Question: In a single sentence, describe what this figure presents.
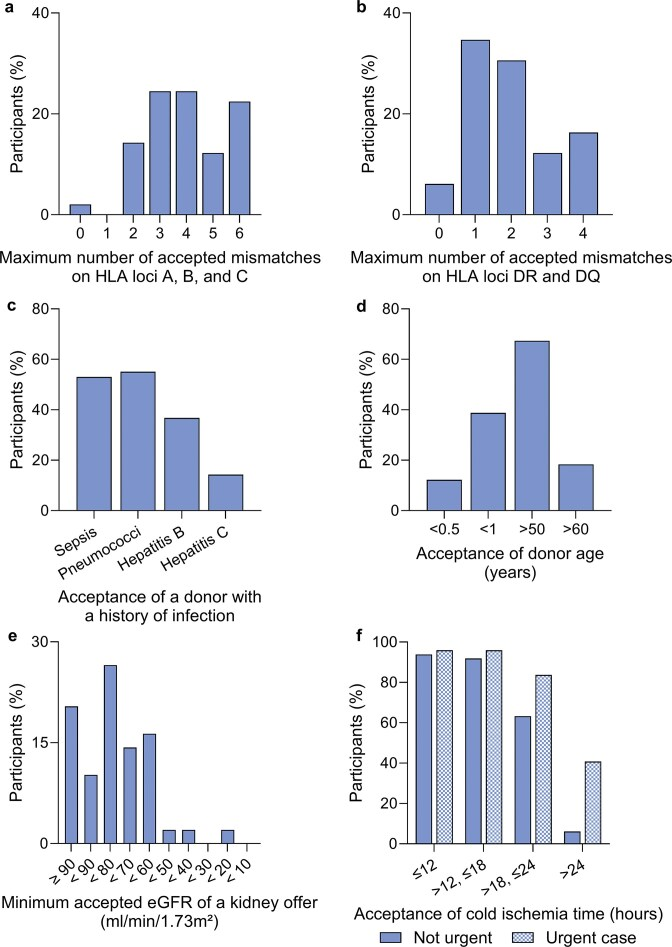
Answer: Precedent survey results. (a) Mostly a maximum of three (12/49, 25%) or four (12/49, 25%) MMs on HLA loci A, B, and C was accepted. Corresponding survey questions: ‘ Regarding ‘acceptable’ MM when a kidney is offered, what is the maximum total number of MM on HLA A, B, and C you would accept: ’. (b) The total number of acceptable MM on HLA DR and DQ was 1 (17/49, 35%) or 2 (15/49, 13%) at maximum in most cases. Corresponding survey questions: ‘ In our center, in order to accept a first kidney, transplant we allow the following maximum total number of MM on HLA DR and DQ: ’. (c) A history of sepsis or an infection with pneumococci in the donor was accepted in 55% (26/47) and 56% (27/48) of the cases, respectively, whereas a history of hepatitis C was mostly declined (42/49, 86%). Corresponding survey question: ‘ Would you accept a kidney from a donor with: ’. (d) Small donors aged <0.5 years were mostly declined (41/47, 87%). However, donors of >50 years were accepted in the majority of cases (33/49, 67%), whereas donors >60 years were mostly declined (40/49, 82%). Corresponding survey question: ‘ Regarding the age of the donor, you would accept a kidney from a donor who is aged: ’. (e) Most responses on the minimum accepted eGFR of an offered kidney ranged between ≥90 and <60 ml/min/1.73 m 2 (43/49, 87.76%). Corresponding survey question: ‘ Regarding the donor’s kidney function, what is the minimal eGFR of an offered kidney that you would accept? ’. (f) CIT of >24 hours were declined in almost all cases (42/45, 93%); however, in urgent cases (marked in a hatched pattern) 43% (20/47) accepted a CIT of >24 hours. Corresponding survey questions: ‘ With regard to CIT, would you accept a deceased donor kidney with CIT: ’ and ‘ With regard to CIT, in clinically urgent cases would you accept a deceased donor kidney with CIT: ’.